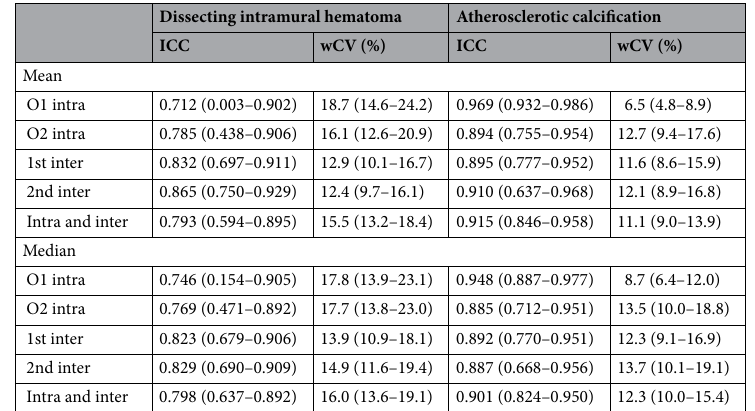
Table 2. Intra- and interobserver reproducibility of QSM values in dissecting intramural hematomas and atherosclerotic calcifications. ICC intraclass correlation coefficient, wCV within-subject coefficient of variation, O1 observer 1, O2 observer 2, intra intraobserver reproducibility, inter interobserver reproducibility, 1st inter interobserver reproducibility between the first measurements of observer 1 and 2, 2nd inter interobserver reproducibility between the second measurements of observer 1 and 2, Intra and inter reproducibility across the first and second measurements of both observer 1 and 2. *Parentheses indicate 95% confidence intervals. **First-order features show both positive and negative values, and thus wCVs were calculated after shifting the values towards either positive or negative sides (towards where a smaller shift was required).